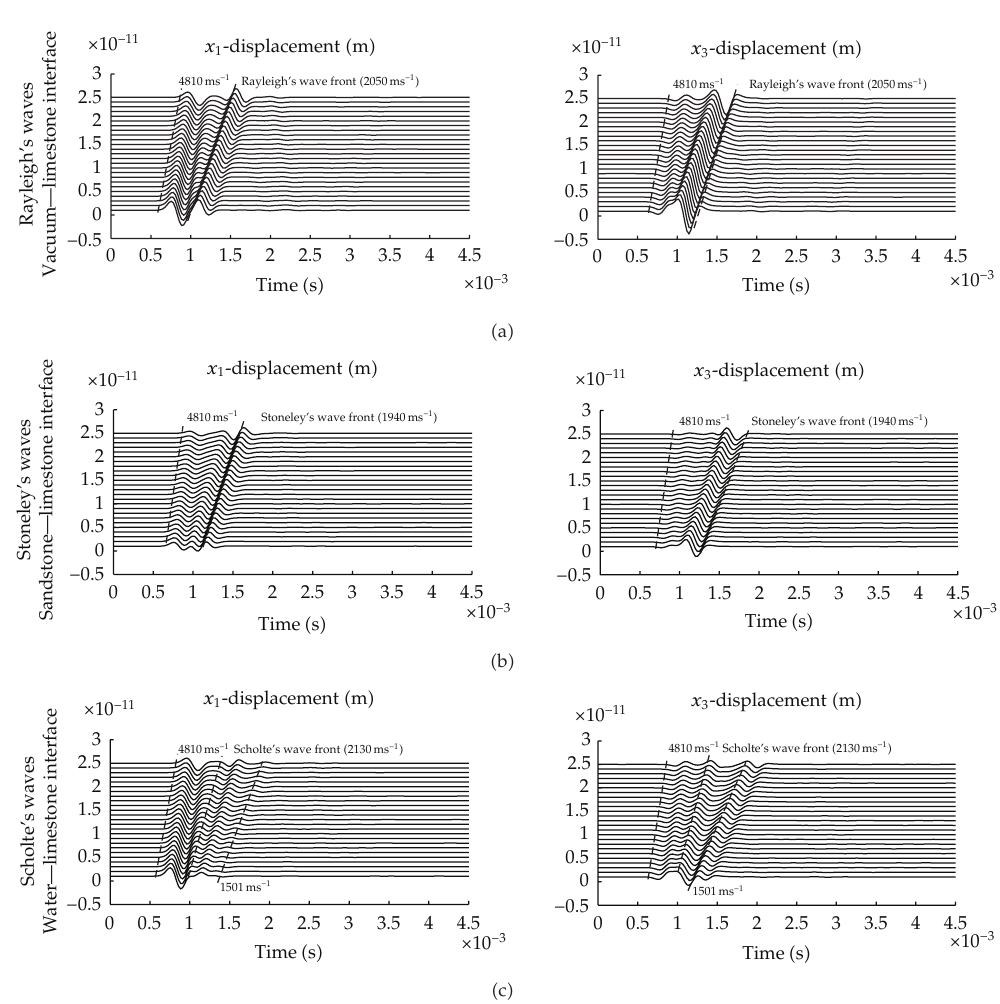
Figure 5: Synthetic seismograms for three di ff erent interfaces. (cid:2) a (cid:5) Vacuum-solid interface, (cid:2) b (cid:5) solid-solid interface, and (cid:2) c (cid:5) fluid-solid interface. x 1 (cid:2) left (cid:5) and x 3 (cid:2) right (cid:5) components of displacement are plotted. Materials 2 from the Table 1 are used for the